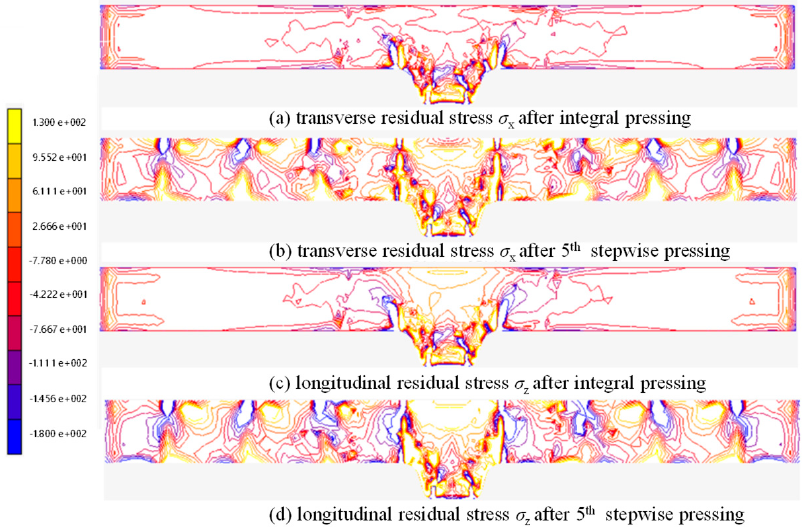
Figure 7. Strain distribution of the first pass of cold pressing.